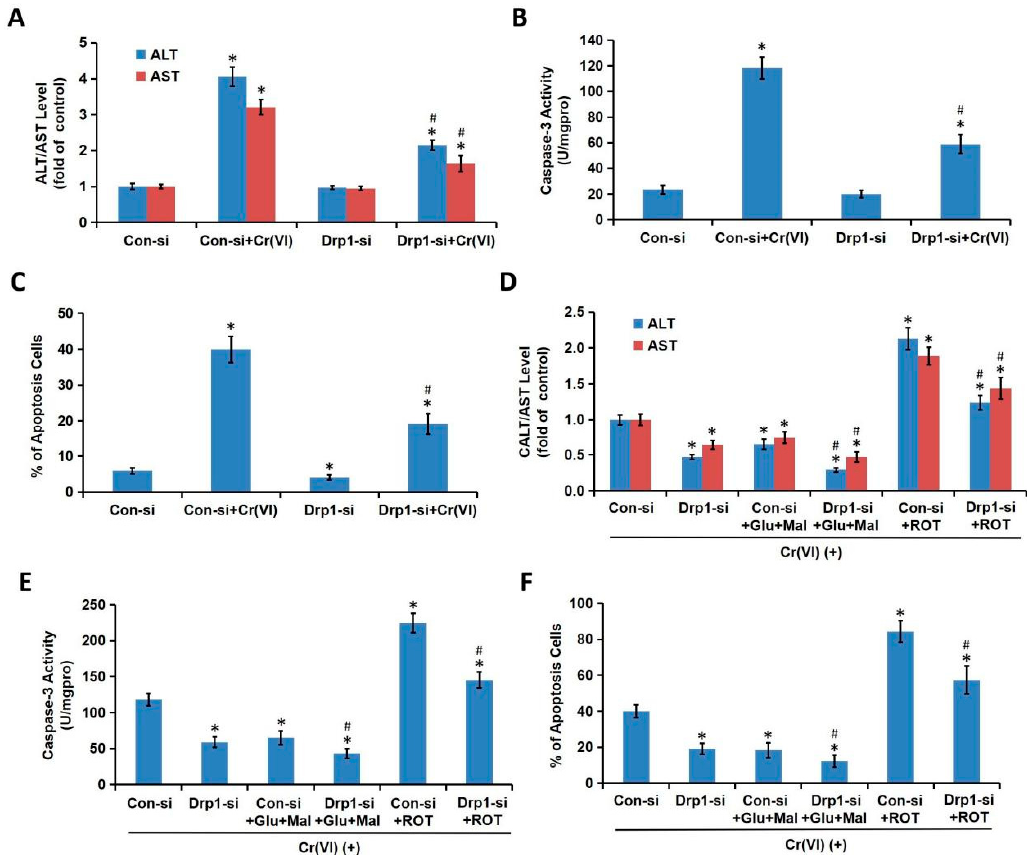
Figure 6. Drp1-mediated mitochondrial fragmentation contributes to Cr(VI)-induced MRCC I- dependent cytotoxicity. ( A ) The L-02 hepatocytes transfected with Drp1-siRNA and Con-si were treated with Cr(VI) (16 µM) or PBS for 24 h. AST/ALT level was determined using the